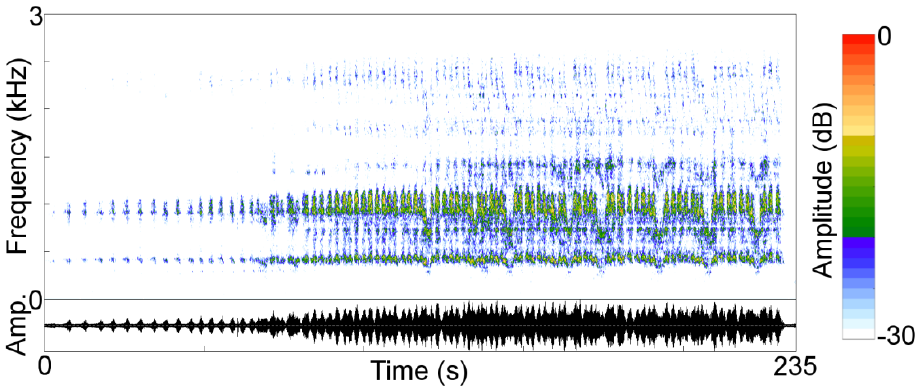
Figure 1. Audiospectrogram (Frequency) and oscillogram (Amplitude) of a typical howling bout of the Guianan red howler monkey in Viruá National Park, Roraima,